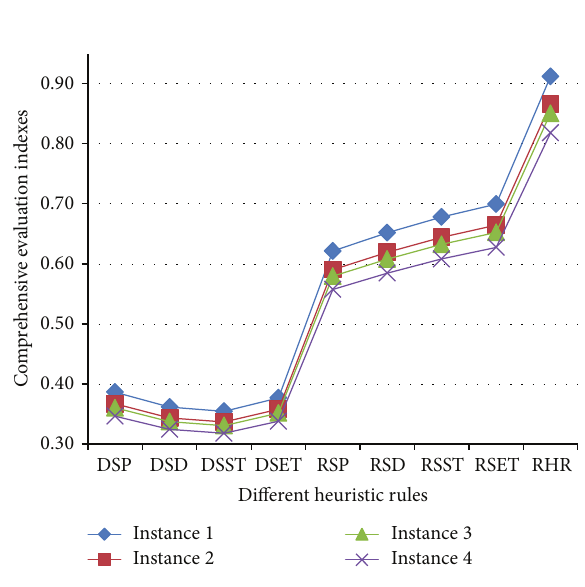
Figure 2: The comparison of comprehensive evaluation